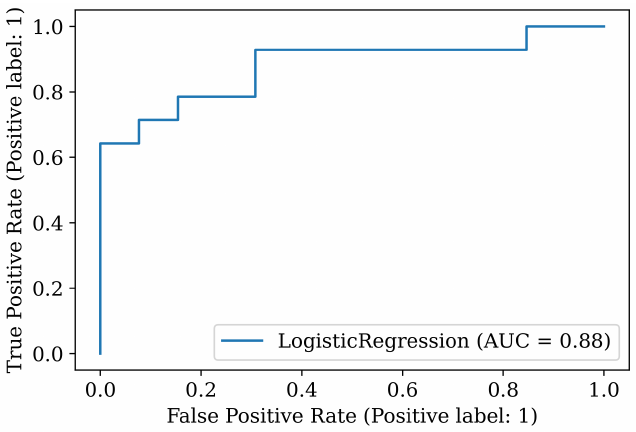
Figure 12. ROC curve for the test set of OrigD and the best LR model. Table 10. Confusion matrix for the test set of OrigD and the best LR model.